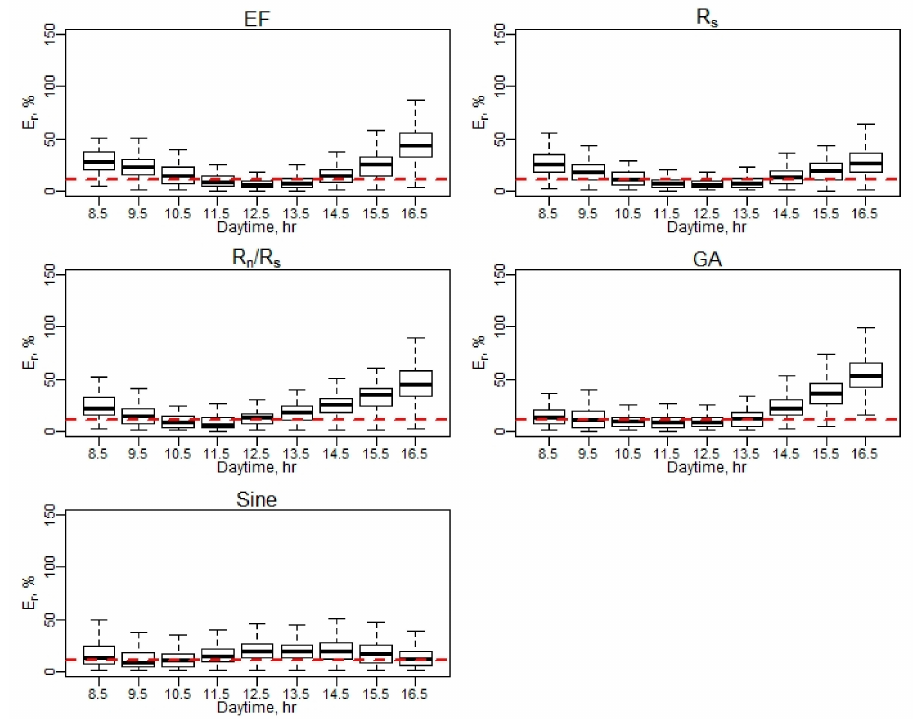
Figure A23. E r of daily EC ET (June–August).